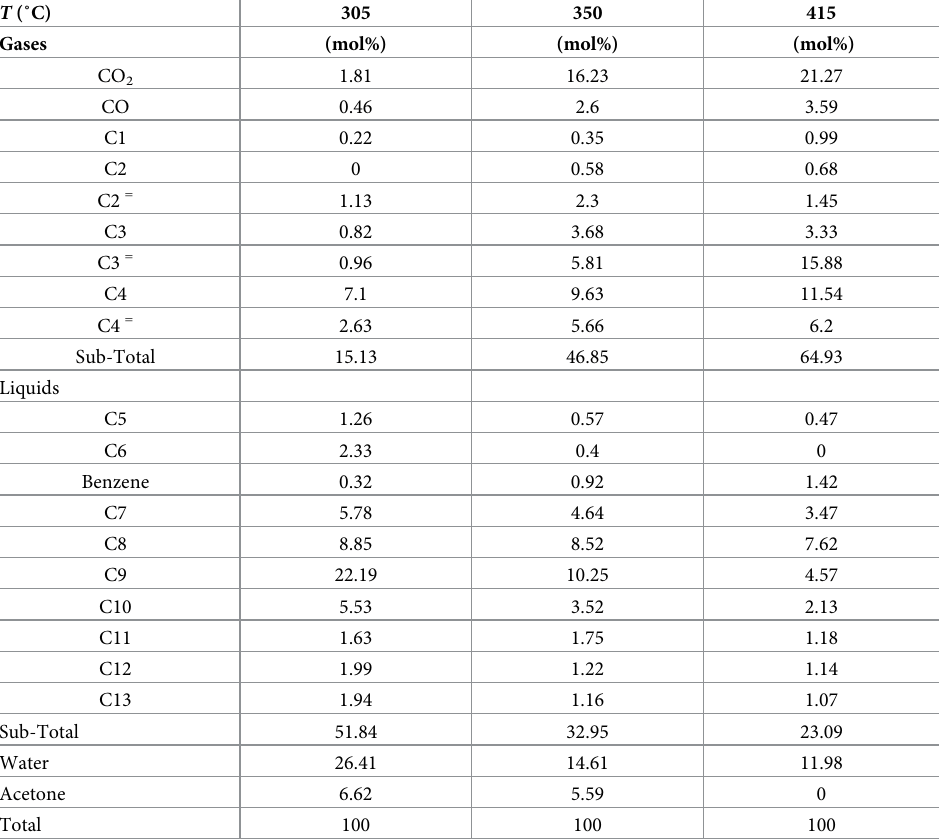
Fig 10. Product distribution of gases and liquids for the acetone reaction over HZSM-5(280), T = 415˚C, P = 790 kPa (abs). https://doi.org/10.1371/journal.pone.0277184.g010 Table 3. Total product distribution for gases and liquids for acetone reaction over HZSM-5(80), T = 305, 350, and 415˚C, WHSV = 1.3 h –1 , and P = 101 kPa